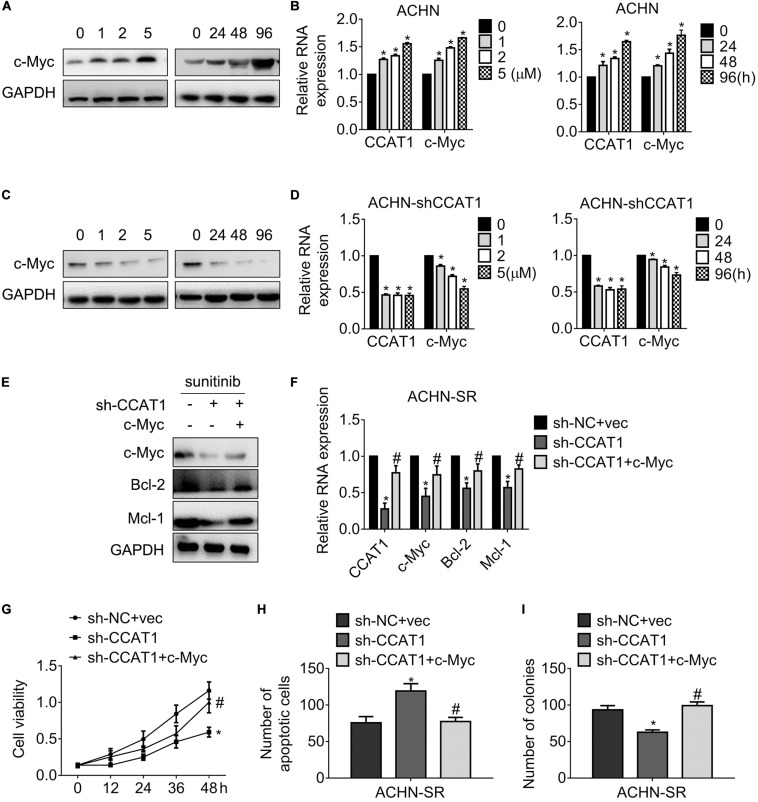
LncRNA CCAT1 drives sunitinib resistance in a c-Myc-dependent manner. (A,B) The expression of c-Myc in ACHN cells were accessed by western blot or qPCR, respectively. Cells were treated with different doses of sunitinib or 5 μM sunitinib for different durations. *P < 0.05 vs. control. (C,D) The expression of c-Myc in CCAT1-deprived ACHN cells were accessed by western blot or qPCR, respectively. Cells were treated with different doses of sunitinib or 5 μM sunitinib for different durations. *P < 0.05 vs. control. (E,F) The expression of the indicated genes was examined by western blot or RT-qPCR, respectively. Cells were introduced into sh-CCAT1 alone or sh-CCAT1 plus c-Myc before exposure with sunitinib. *P < 0.05 vs. sh-NC + vector; #P < 0.05 vs. sh-CCAT1. (G) The viability of the indicated cells was measured by MTT assay. (H) The apoptosis of the indicated cells was measured by Hoechst 33258 staining. (I) The clonogenicity of the indicated cells was measured by colony formation. *P < 0.05 vs. sh-NC + vector; #P < 0.05 vs. sh-CCAT1. Results represented the mean ± SD of three independently repeated experiments. Cells were exposed to 2.5 μM sunitinib apart from the indicated doses.